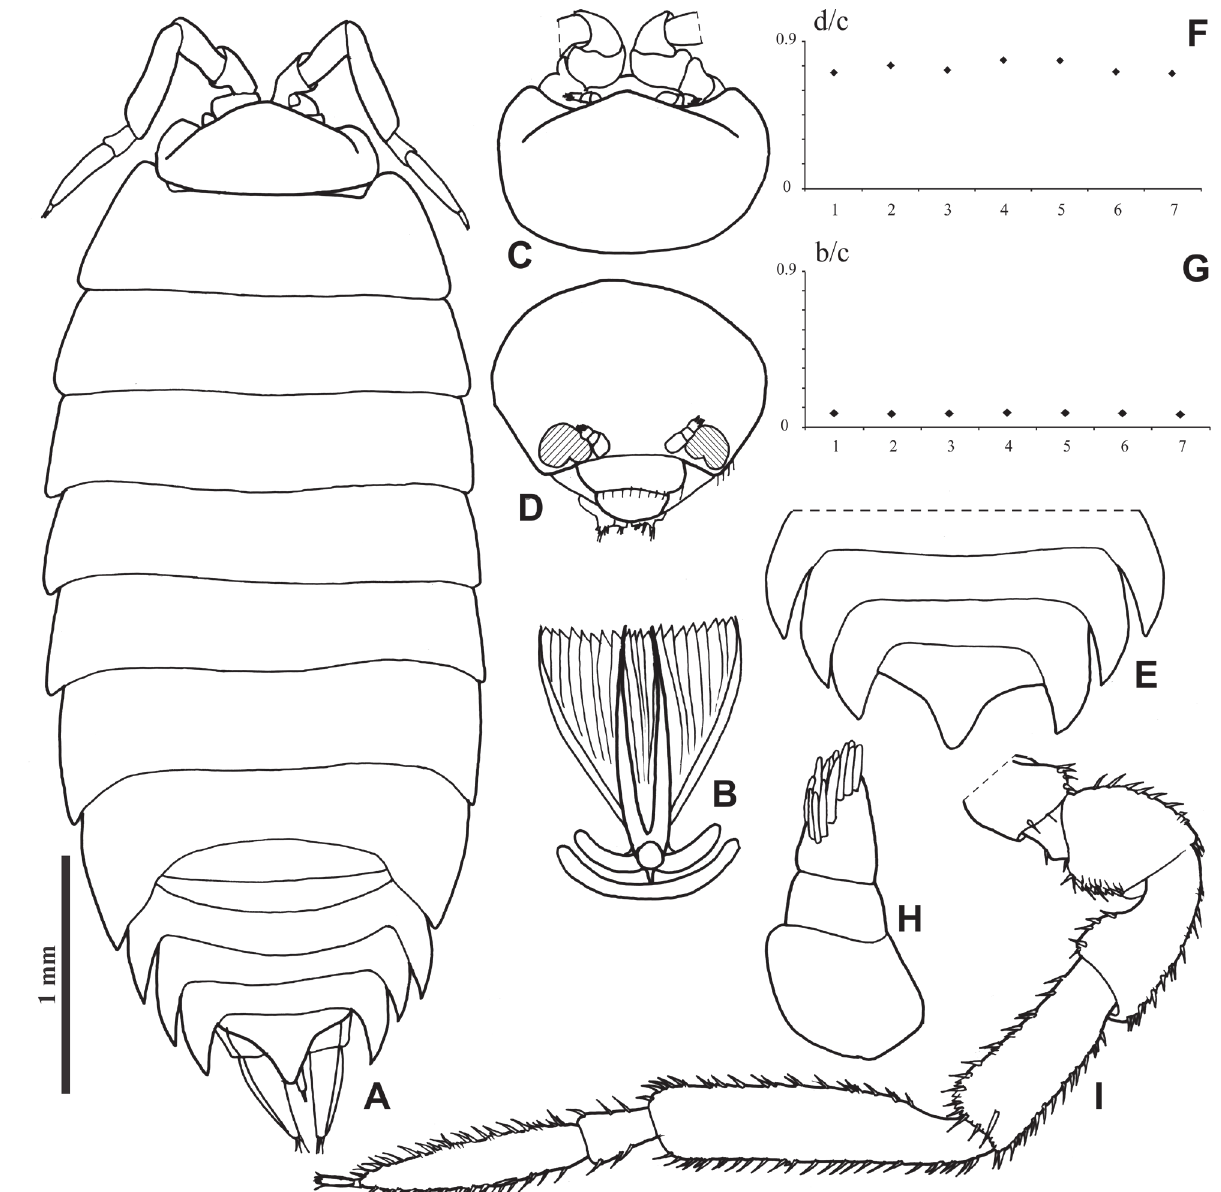
Figure 11. Trichorhina pataxosi n. sp. (male paratype). A, dorsal habitus; B, dorsal scale-seta; C, cephalon, dorsal view; D, cephalon, frontal view; E, pleonites 3–5 and telson; F, d/c coordinates of noduli laterales; G, b/c coordinates of noduli laterales ; H, antennula; I,